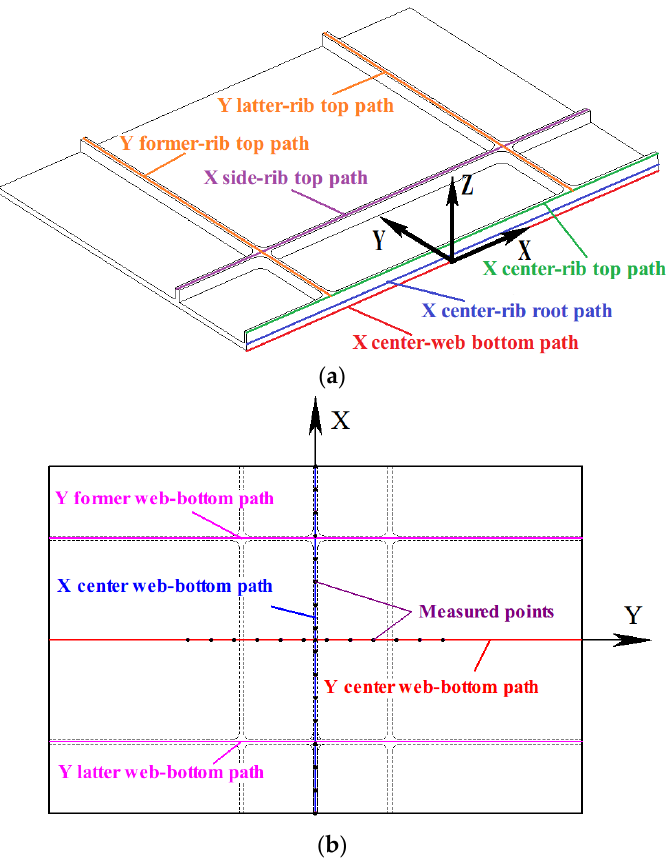
Figure 11. The defined paths of the grid-rib panel: ( a ) from the top view of the panel, 1/2 model shown only; and ( b ) from the bottom view of the panel.